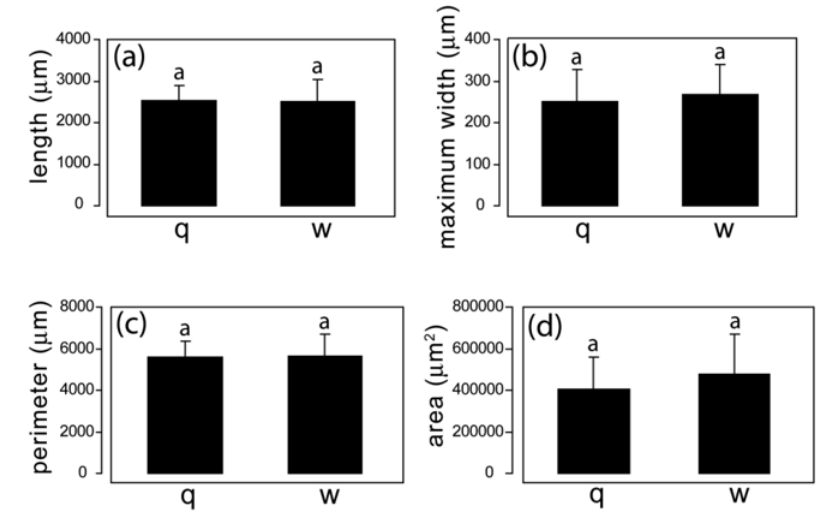
Fig 2: Mean and standard deviation of (a) length of the Dufour’s gland, (b) maximum width of the gland, (c) perimeter of the gland’s image and (d) area covered by the gland’s image in queens (q) and workers (w) of Ropalidia marginata . bars are carrying the same letter signifying that there is no difference between queens and workers for any of the four variables (ANOVA, p > 0.05, n = 6 queens and 36